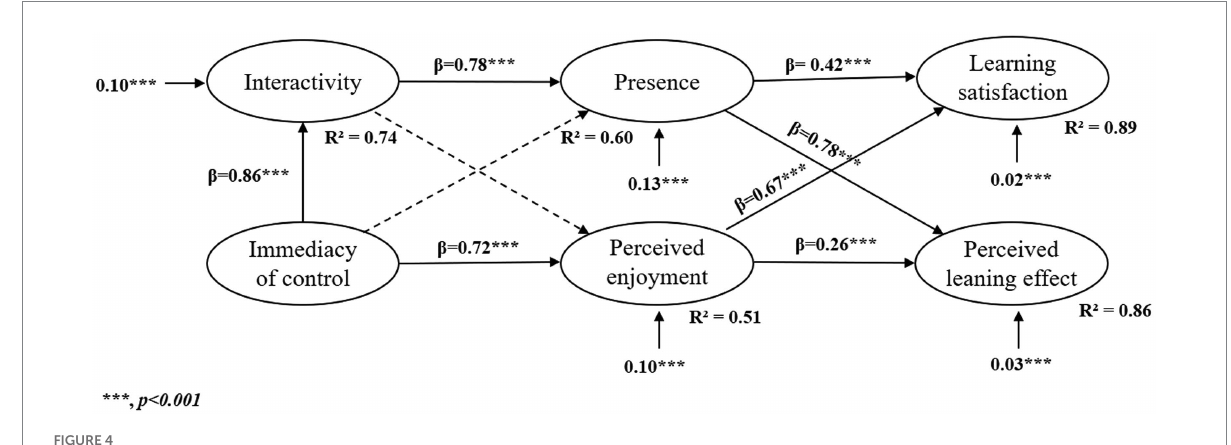
FIGURE 4 Structural model with results.